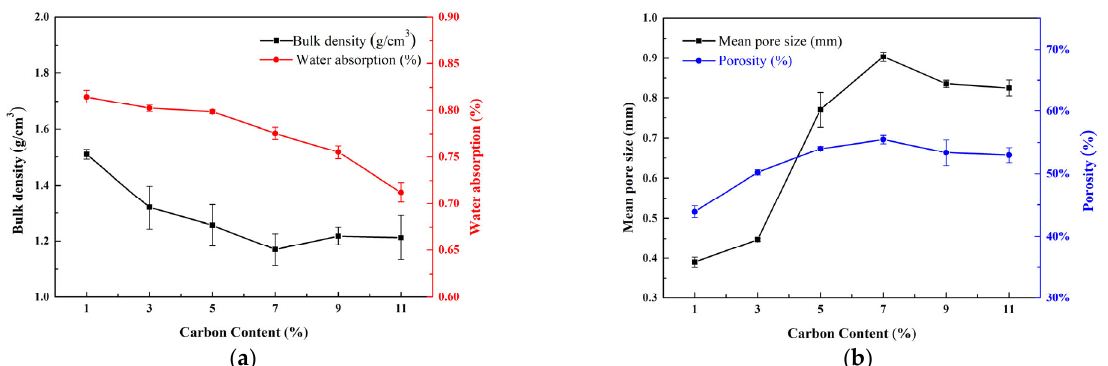
Figure 8. ( a ) Bulk density and water absorption and ( b ) mean pore size and porosity with different carbon contents at 1200 °C for 20 min.